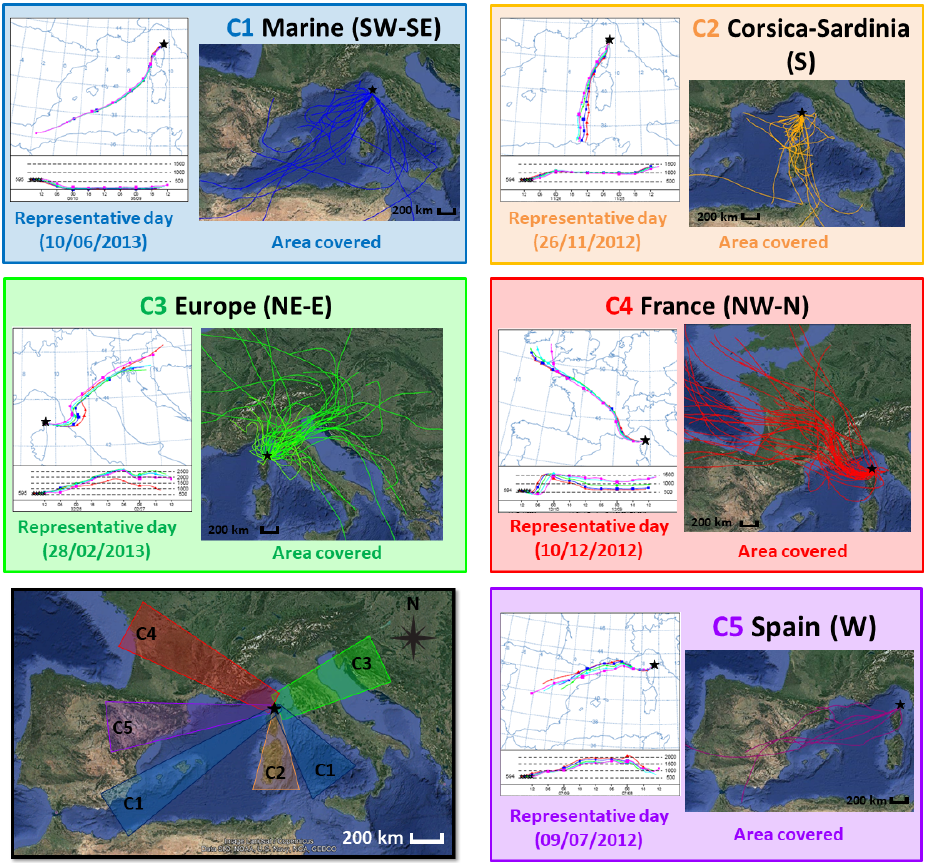
Figure 2. Classification of air masses which impacted the Ersa site during the 2-year observation period as a function of their trajectory. Back-trajectories simulated with the HYSPLIT Lagrangian model were classified into five clusters: Marine (cluster 1 – wind sectors SW and SE), Corsica–Sardinia (cluster 2 – S), Europe (cluster 3 – NE–E), France (cluster 4 – NW–N) and Spain (cluster 5 – W). These five clusters were illustrated by example maps with five trajectories (interval of 1h between each, time of arrival indicated by different colours of trajectory, the Ersa station represented by a black star) for 5d that are representative of an isolated cluster. Finally, areas covered by back-trajectories of each cluster are also indicated. Maps provided by Google Earth Pro software (v.7.3.3; image Landsat/Copernicus; data SIO, NOAA, U.S. Navy, NGA, GEBCO; © Google